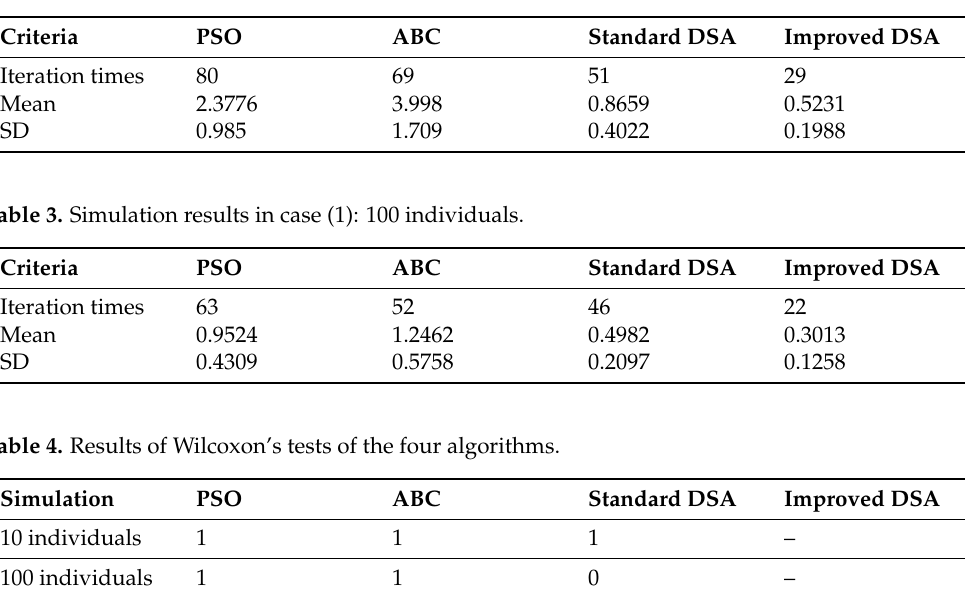
Table 2. Simulation results in case (1): 10 individuals.